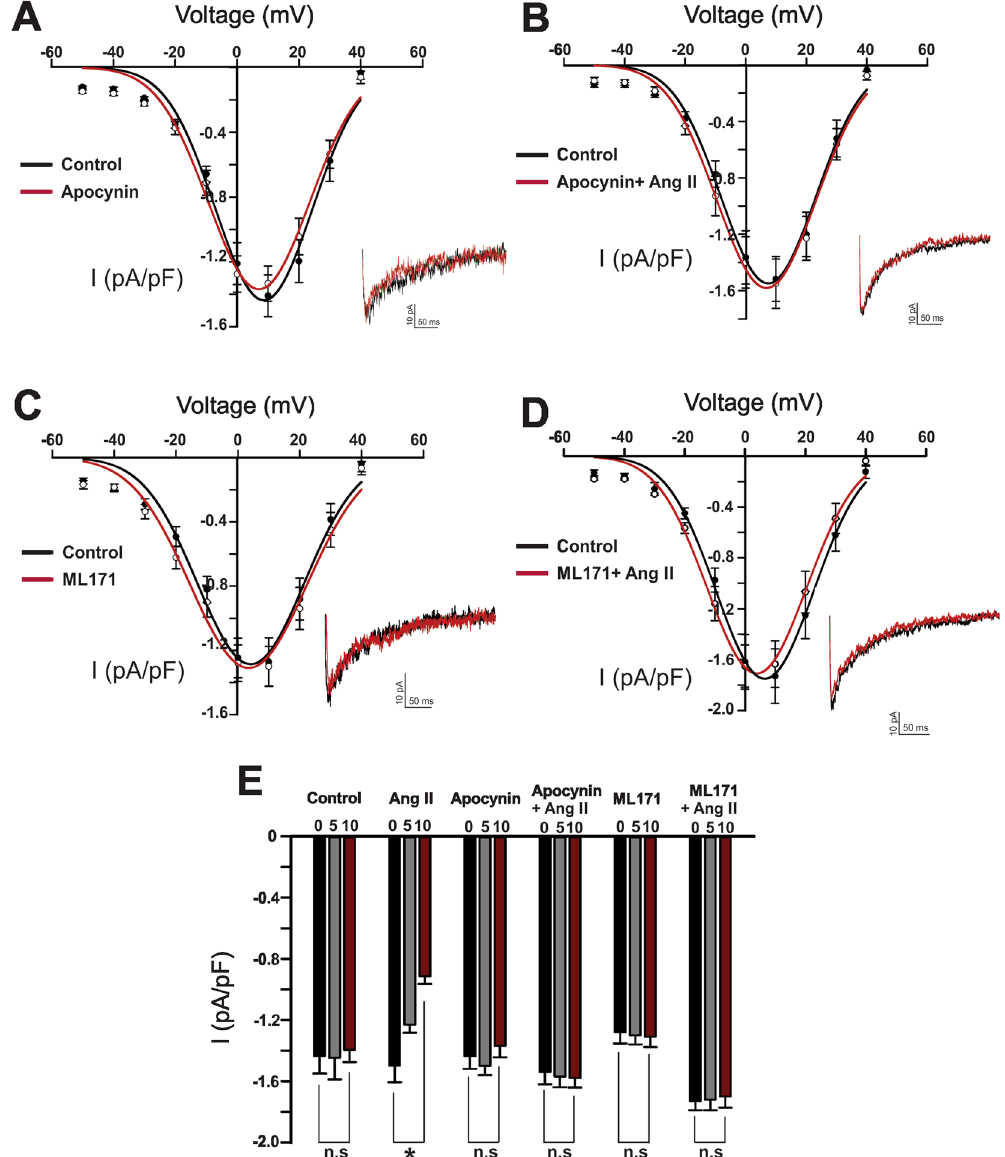
Figure 3. NADPH oxidase (Nox) inhibition abolishes angiotensin II suppression of the T-type Ca 2 + current. ( A ) Representative trace, and averaged I-V plots of the whole cell T-type current, prior to and following the application of apocynin (non-selective Nox inhibitor, 50 µ M) (n = 7). ( B ) Representative trace and averaged I-V plot highlighting the inability of Ang II (100 nM) to inhibit the T-type current in cells incubated with apocynin (n = 8). ( C ) Representative trace, and averaged I-V plots of the whole cell T-type current, prior to and following the application of ML171 (selective Nox 1 inhibitor, 1 µ M) (n = 7). ( D ) Representative trace and average I-V plot highlighting the inability of Ang II (100 nM) to inhibit the T-type current in cells incubated with ML171 (n = 7). ( E ) Peak T-type current (pA/pF) at 5 min time intervals under control condition (n = 8) or in cells treated with either apocynin or ML171 ± Ang II (n = 7–8). * Denotes significant difference compared to control ( * P < 0.05, paired t